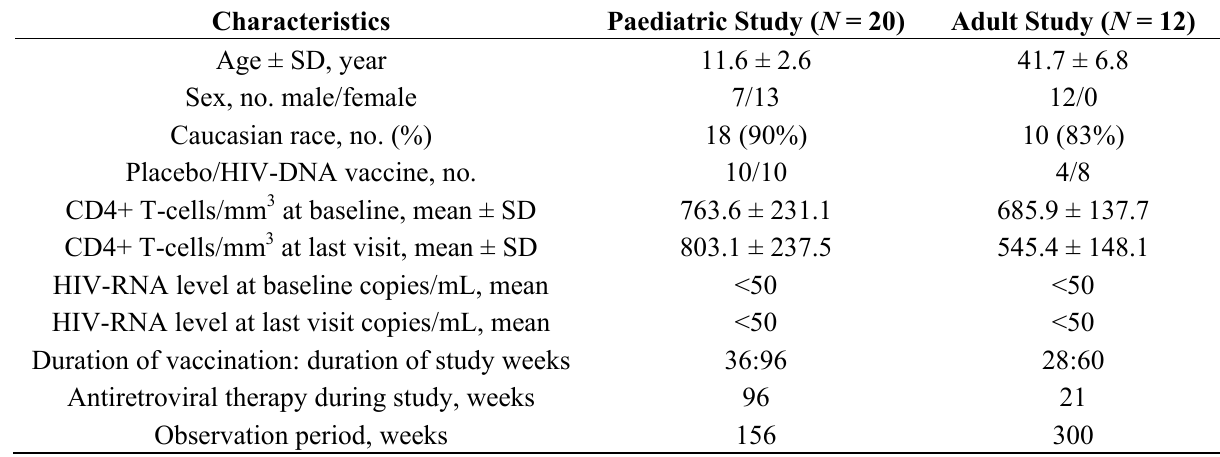
Table 1. Demographic characteristics of paediatric and adult